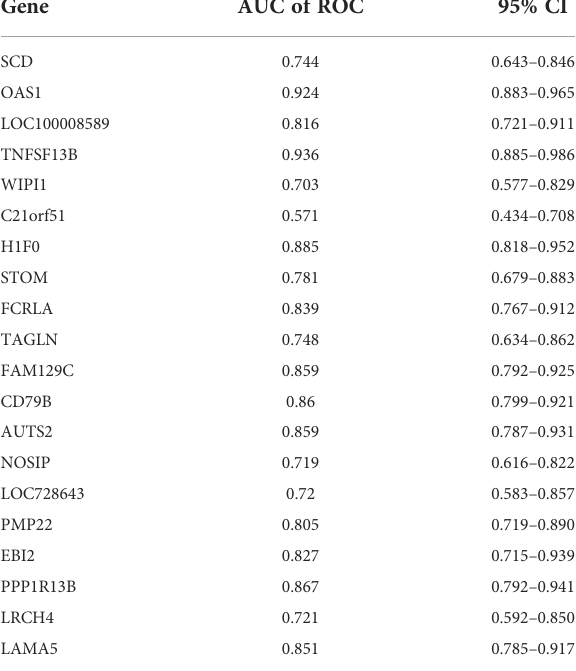
TABLE 1 AUC of 20 hub